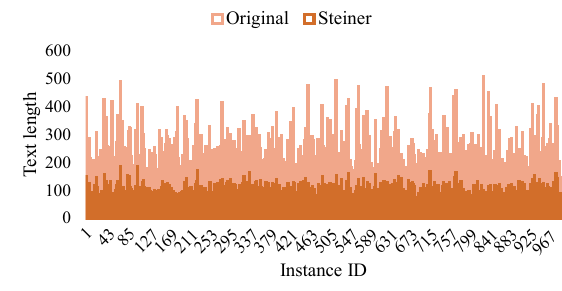
Fig. 8 Text lengths distribution on DocRed.